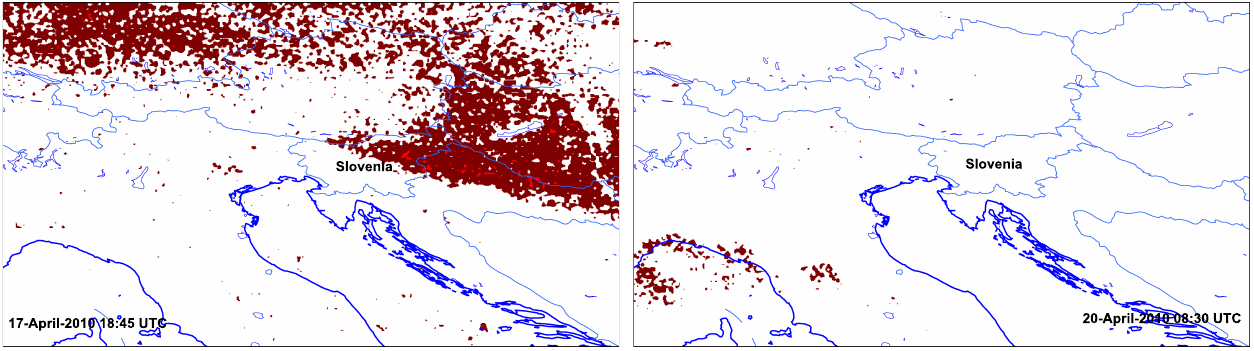
Fig. 14. Meteosat-9 satellite data from Spinning Enhanced Visible and Infrared Imagery show the presence of volcanic ash over Slovenia in detectable quantities on 17 April (left) and its absence on 20 April 2010 (right). Dark red areas indicate the brightness temperature difference below − 0 . 5K and red areas below − 1K from channels centered at 10 . 8µm and